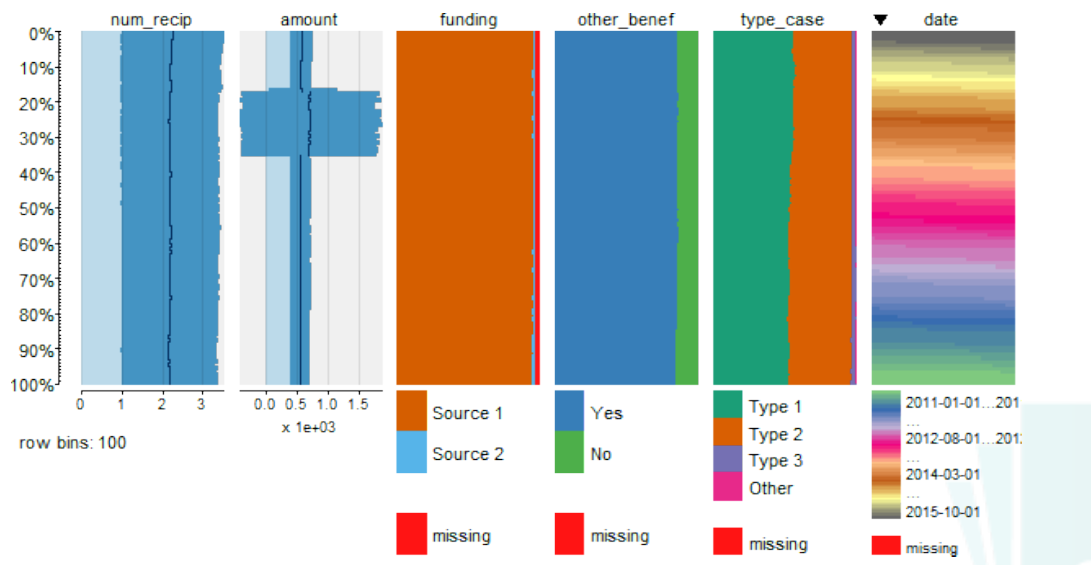
Figure 3: Example letter-value plots for simulated